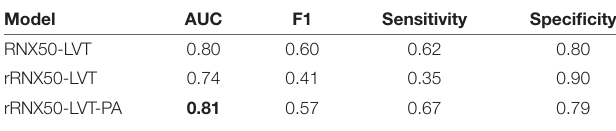
TABLE 3 | Analyzing different architectures of Chest L-Transformer (classification).